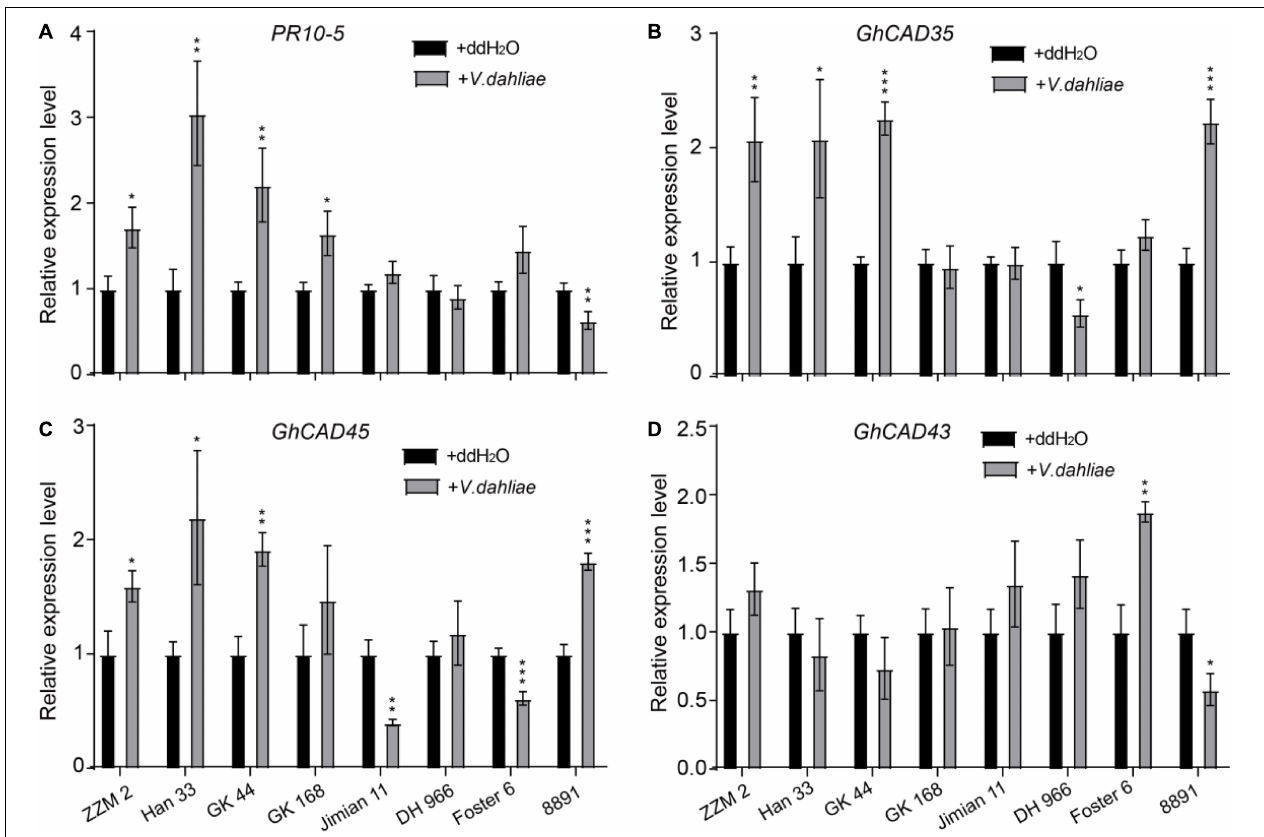
FIGURE 3 | Different expression patterns of GhCAD35 and GhCAD45 in G. hirsutum resistant- and susceptible-cultivars 24 h after V. dahliae inoculation. (A–D) The transcriptional levels of PR10-5 , GhCAD35 , GhCAD45 , and GhCAD43 under the control (ddH 2 O) and V. dahliae treatment conditions in different G. hirsutum cultivars. Four Verticillium wilt resistant cultivars (ZZM 2, Han 333, GK 44, and GK 168) and four Verticillium wilt susceptive cultivars (Jimian 11, DH 966, Foster 6, and 8891) were used in the V. dahliae inoculation experiment; two-weeks-old plants 24 h after V. dahliae inoculation were used in qRT-PCR analysis. Three biological replicates were performed for each treatment. The gene expression level in each cultivar under the control (ddH 2 O) conditions was normalized as 1. GhUBQ7 was used as reference gene. The data represent the mean ± SD ( n = 3 biological replicates), * P < 0.05, ** P < 0.01, *** P < 0.001 (Student’s t